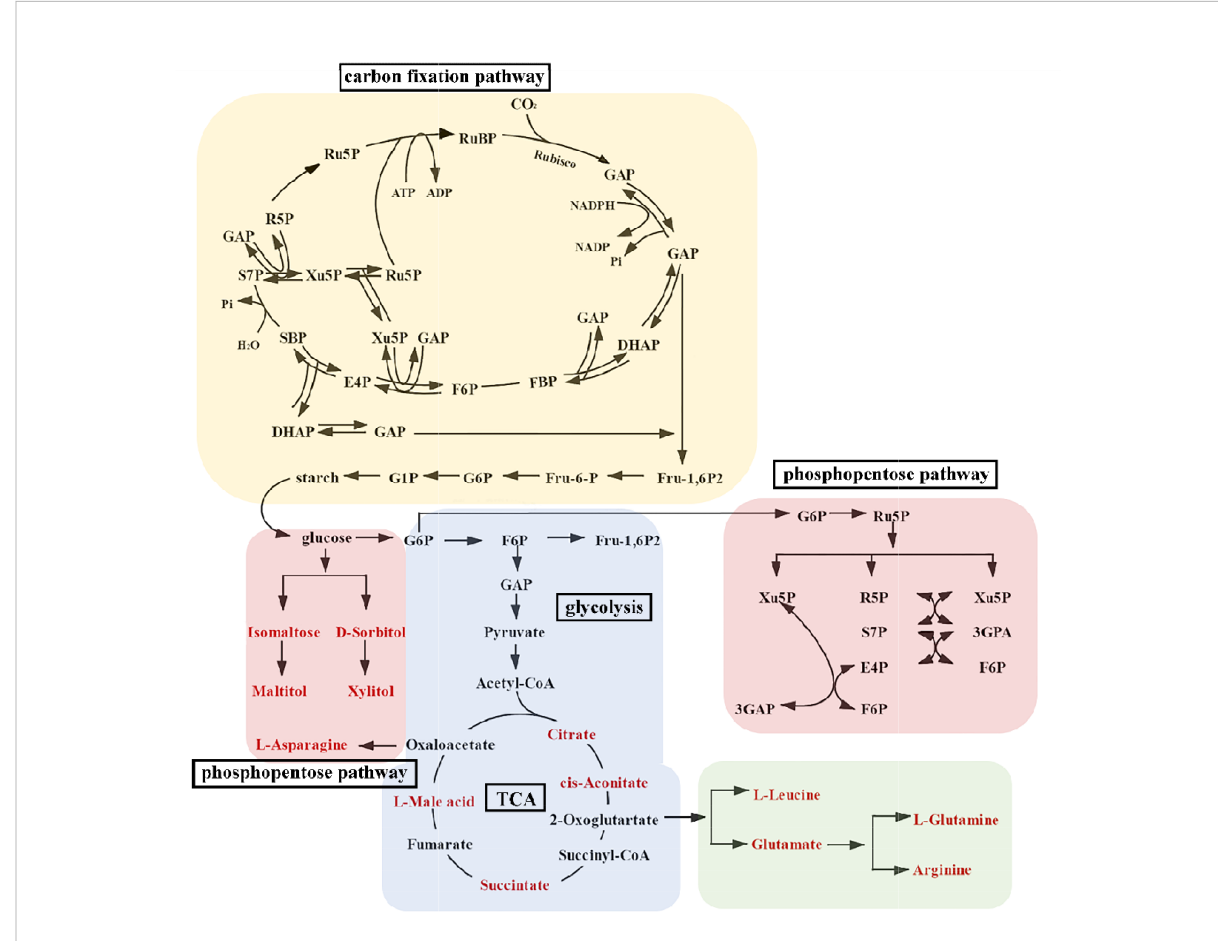
FIGURE 2 Model of central carbon cycle metabolism in S. thunbergii. The red names represent metabolites with signi fi cantly differences between female and male algae. The abbreviations for metabolites are: Ru5P, d-xylulose 5-phosphate; RuBP, ribulose-1,5-bisphosphate; 3GAP, glycerate-3-phosphate; GAP, glyceraldehyde-3-phosphate; DHAP, dihydroxyacetone phosphate; FBP, fructose-1,6-diphosphate; F6P, fructose-6-phosphate; E4P, erythrose-4-phosphate; SBP, sedoheptulose-1,7-bisphosphatase; S7P, Sedoheptulose 7-phosphate; Xu5P, xylulose 5-phosphate; R5P, ribose5- phosphate; F-1, 6P2, fructose 1, 6-bisphosphate; Fru-6-P, fructose-6- phosphate; G6P, glucose-6-phosphate; G1P,